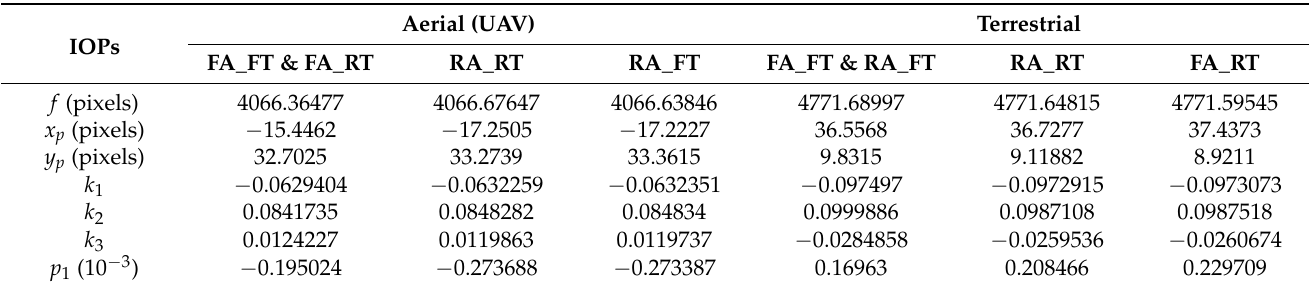
Table 7. IOPs of aerial (UAV) and terrestrial images after the BA of the Lohnhalle dataset using different SC strategies.